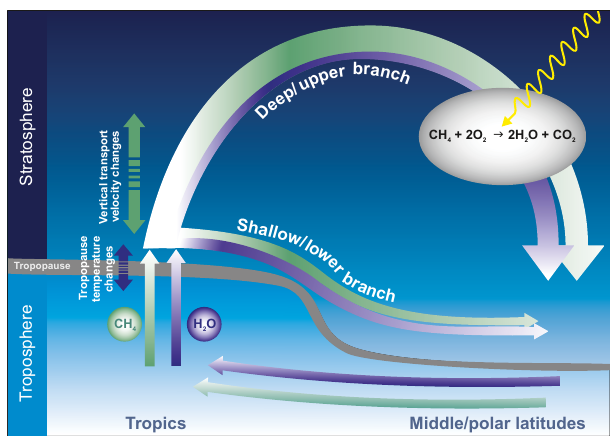
Figure 1. Simplified schematic view of transport pathways within the Brewer–Dobson